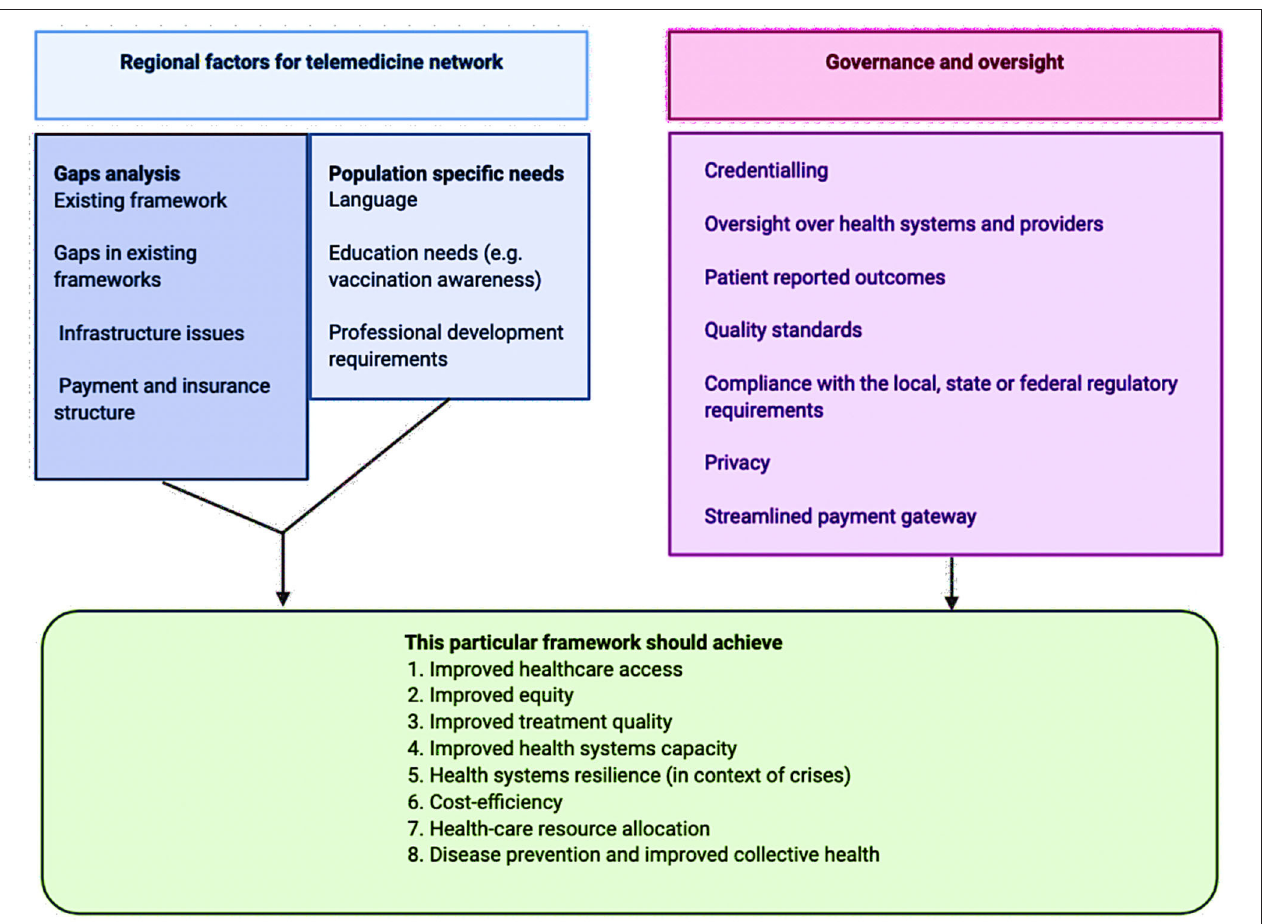
FIGURE 1 | Various regional and structural factors in telemedicine framework development and implementation.